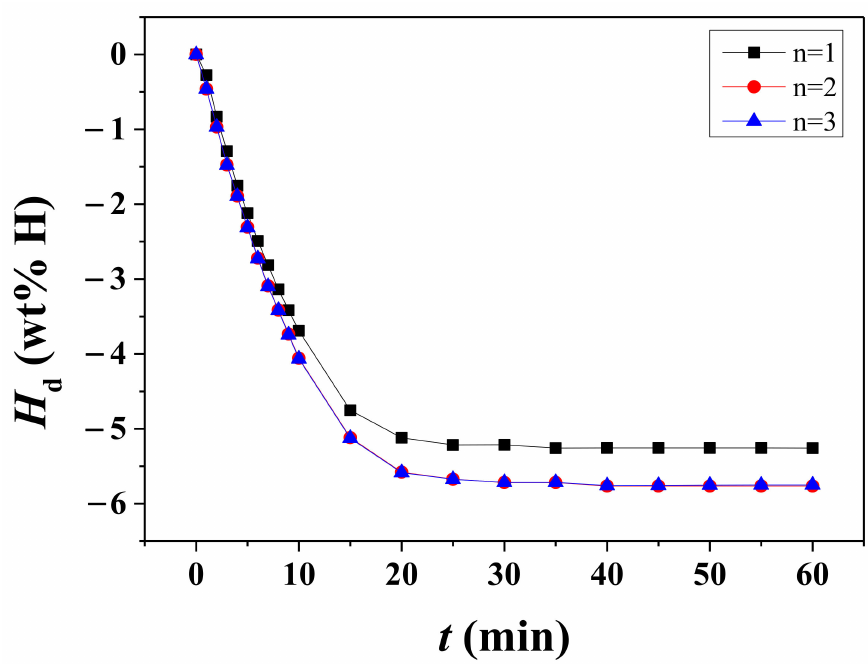
Figure 3. Variation in the H d versus t curve with the number of cycles, n , at 593 K under 1.0 bar H 2 for hydrided